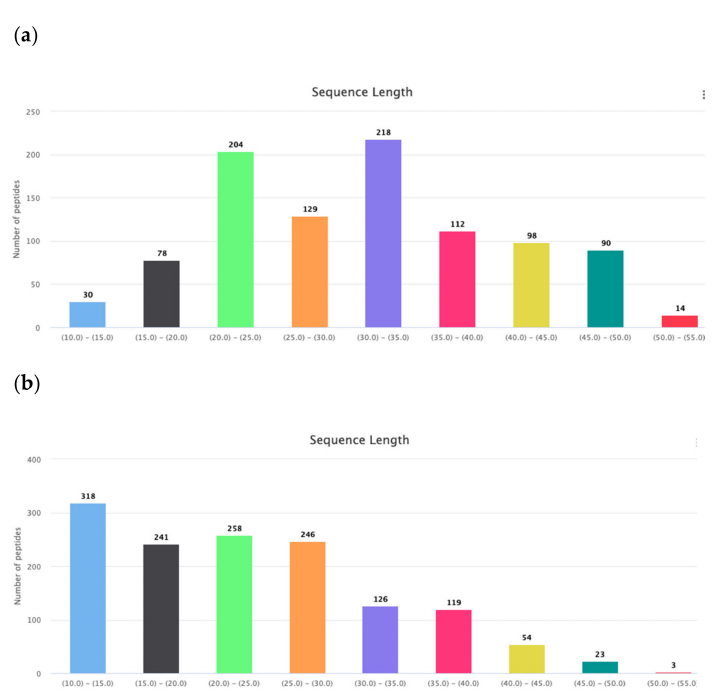
Figure 5. AMP’s lengths distributions for: ( a ) disulfide-bonded and ( b ) linear peptides (according to the data of DBAASP (https://dbaasp.org/statistics, accessed on 20 March